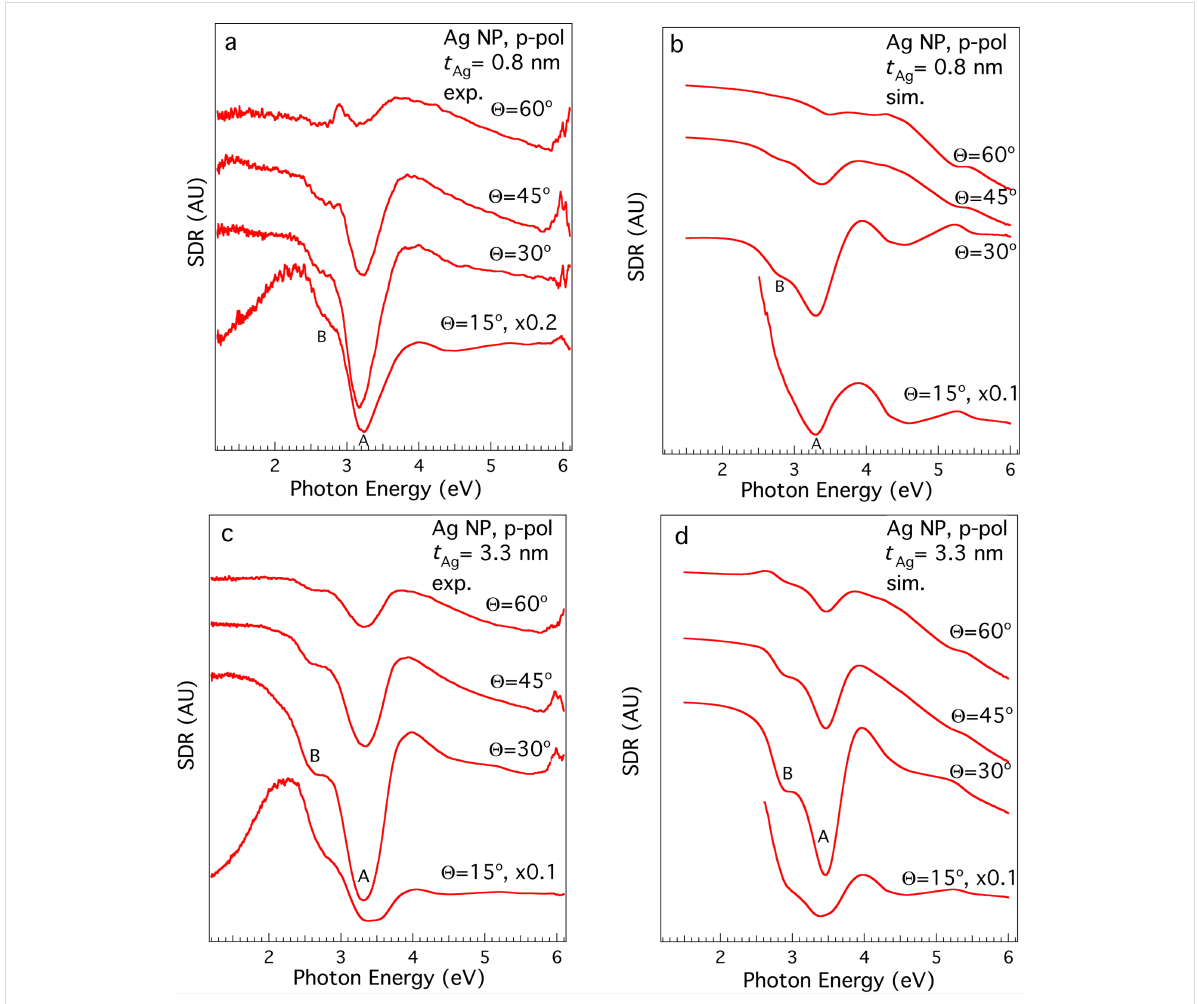
Figure 4: (a) SDR spectra of bare Ag NPs deposited on Si/SiO x , t Ag = 0.8 nm, taken under p-polarisation at different values of Θ . (b) Simulated SDR spectra for a 0 . 8 nm nominal thickness of the AgNP layer ( t Ag ). The calculations were performed at varying incidence angles according to the experi- ment from (bottom) almost grazing incidence to (top) almost normal incidence. The spectra refer to the deposition of bare Ag NPs. (c) Experimental p-polarised SDR data for t Ag = 3 . 3 nm. (d) Simulated SDR spectra for t Ag = 3.3 nm.